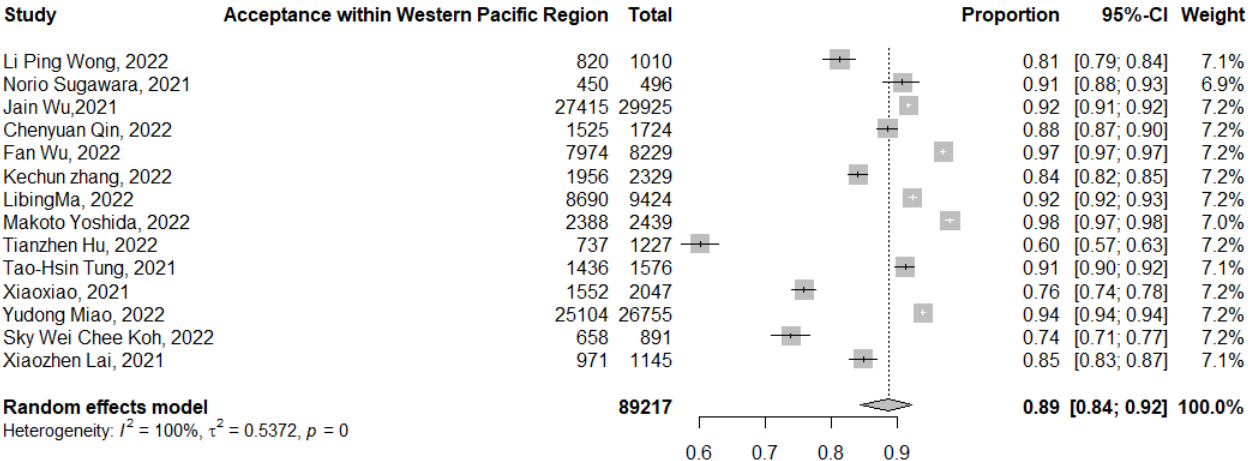
Figure 9. Acceptance of COVID-19 booster dose vaccination in the WHO Western Pacific region. p = 0 denoted a p -value < 0.001.